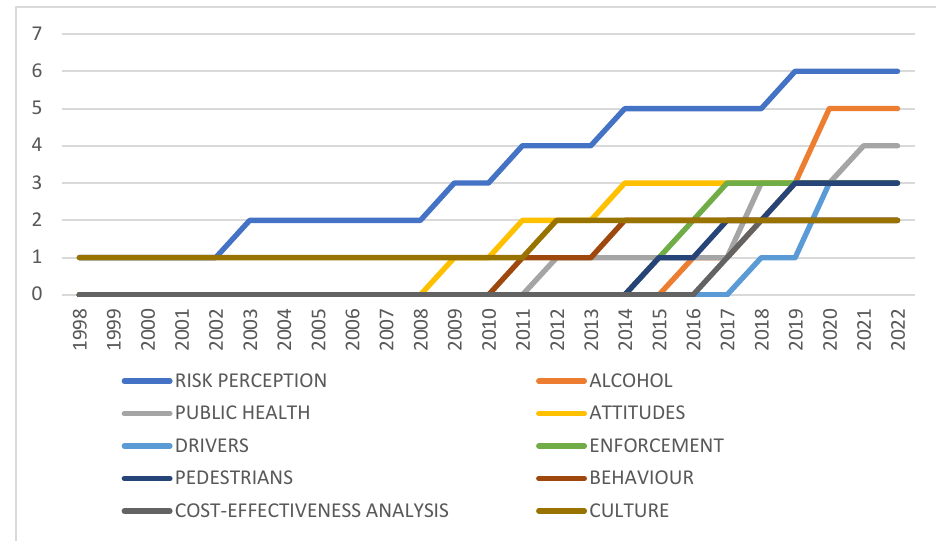
Figure 7. Author keyword frequency. Source: Author’s own, based on Web of Science s earch.